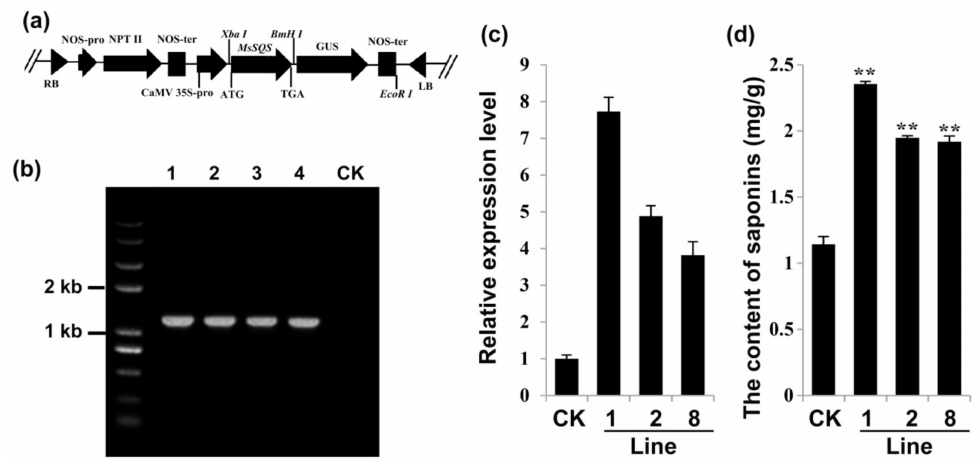
Figure 7. Generation of the transgenic alfalfa harboring 35S::MsSQS construct and analysis of MsSQS level and saponin content in MsSQS- overexpression alfalfa plants. ( a ) Illustration of the MsSQS overexpression vector with Xba I and Bam HI used to subclone MsSQS into pBI-121; ( b ) Verification of the 35S::MsSQS construct in alfalfa plants resistant to kanamycin by PCR using plasmid or genomic DNA as template (Lane 1–4); Lane 1: plasmid harboring 35S::MsSQS was used as the positive control, Lane 2–4: three independent transgenic alfalfa lines (Line 1, Line 2 and Line 8, respectively), CK: transgenic alfalfa expressing pBI-121 (the negative control). ( c ) Analysis of the relative expression level of MsSQS in leaves by qRT-PCR in the three representative transgenic lines. The transgenic alfalfa expressing pBI-121 was used as the control; ( d ) Content of total saponins (mg / g) in leaves (dry weight) of the indicated transgenic lines. Bars represent the mean ± SD of three biological replicates. ** indicates p < 0.01 (Student’s